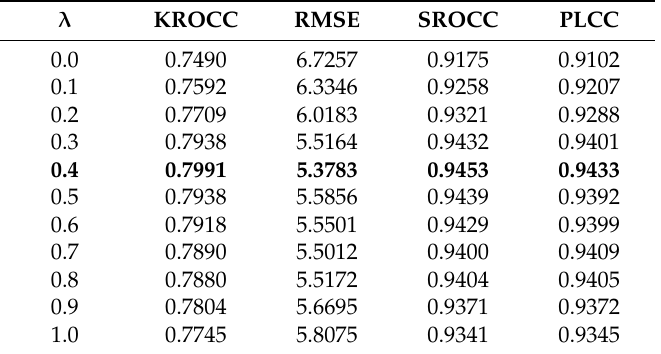
Table 3. Performance of ROI-BRISQUE which ROI extracted by GBVS model. The numbers in bold are the best values.